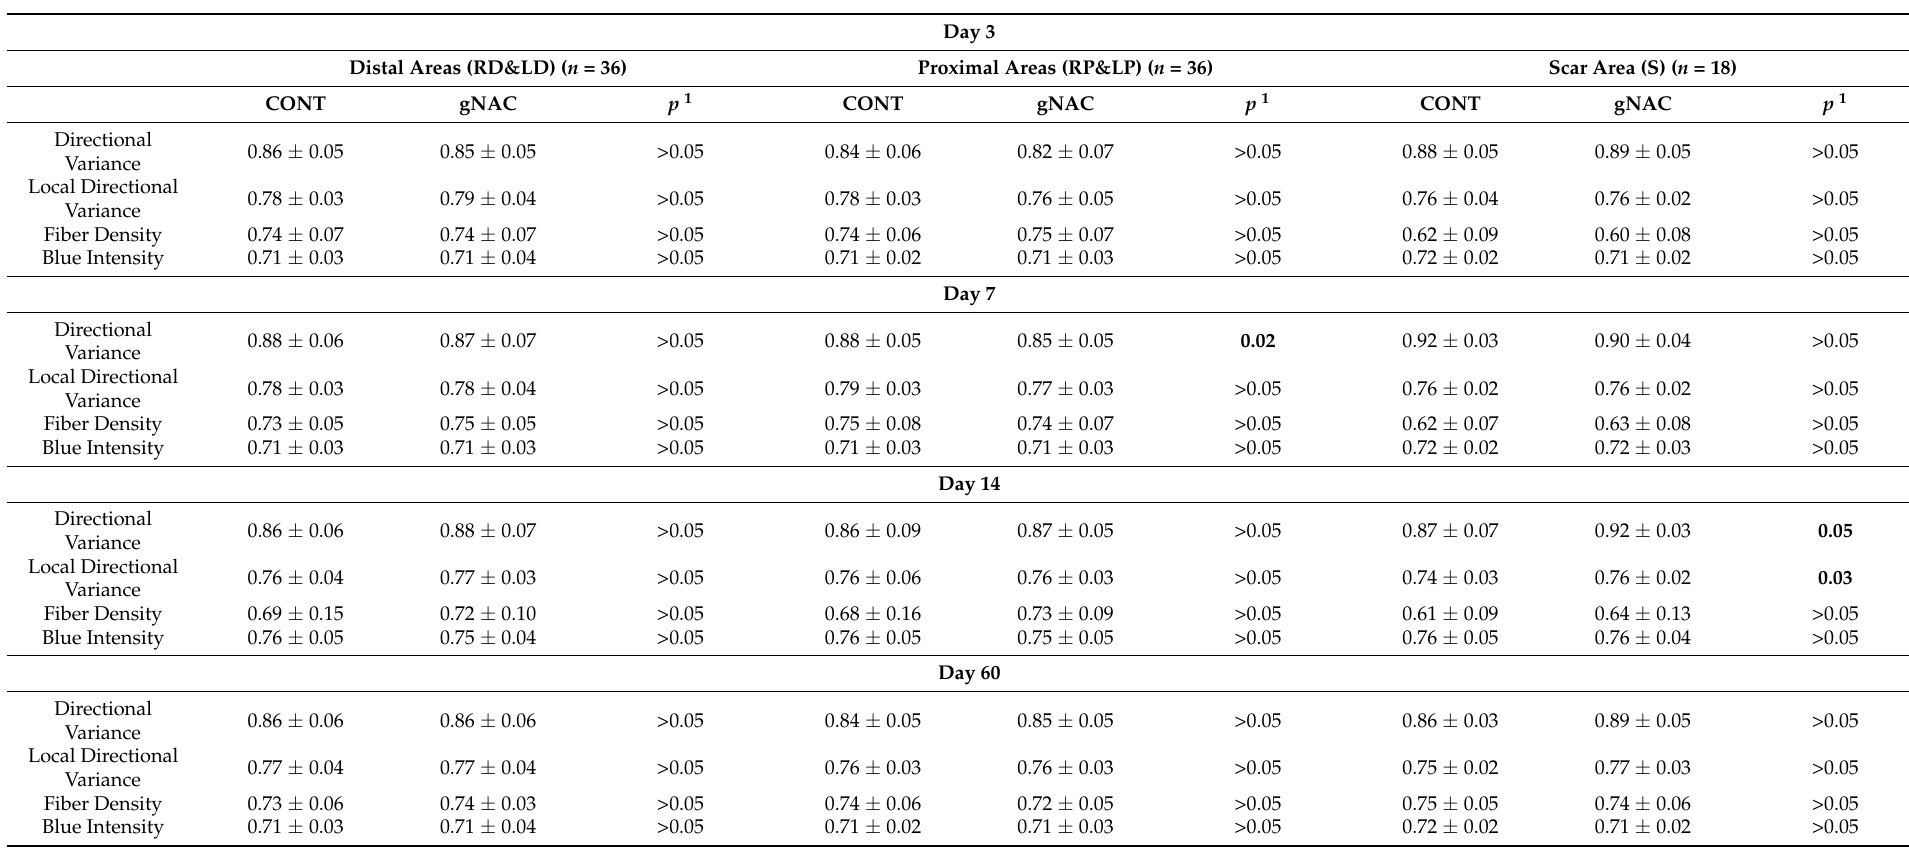
Table 2. Results obtained from automated analysis of collagen fiber setting on TM-stained sections. Values expressed as mean ± SD; 1 — t -test for gNAC vs. CONT. Bolded results are statistically